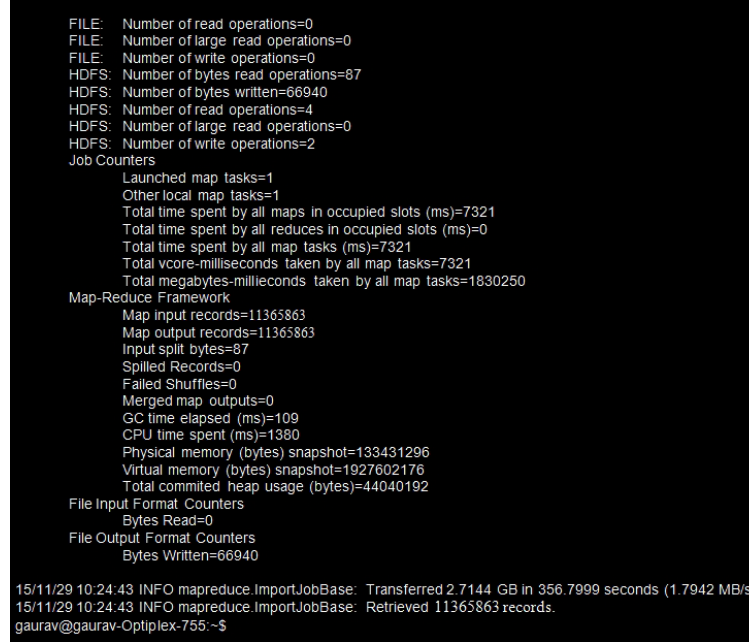
Figure 7 . Loading data in HDFS in